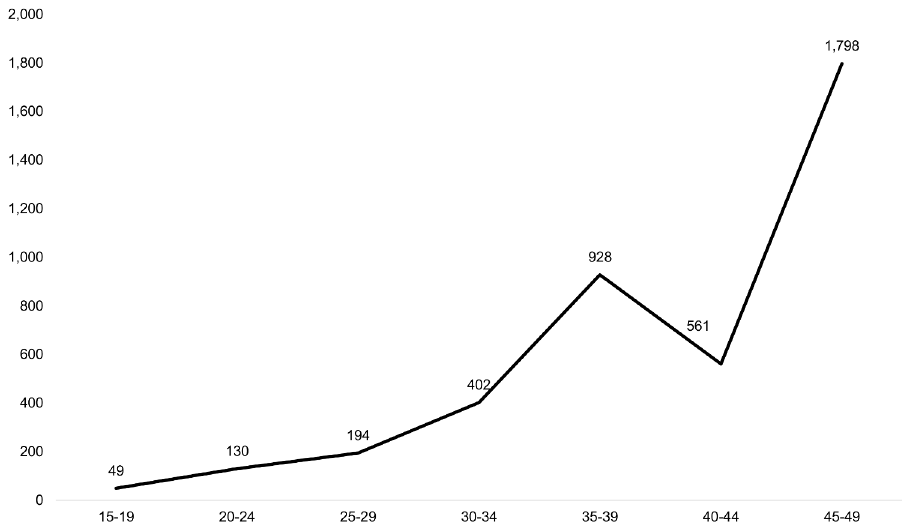
Fig 2. MMR per 100,000 live births by age group, Bangladesh